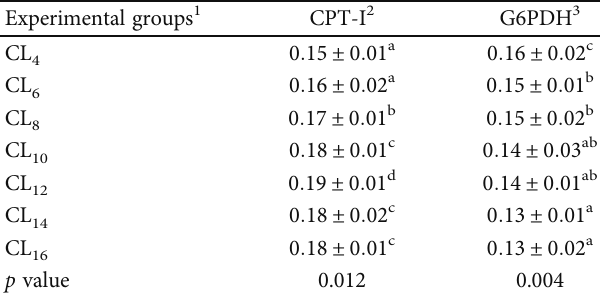
Data are expressed as mean ± SE ( n = 3 pooled fi sh per tank). Mean values in the same column with di ff erent superscripts di ff er signi fi cantly ( p < 0 : 05 ). Glucose-6-phosphate dehydrogenase, mM phosphorus released/min/mg